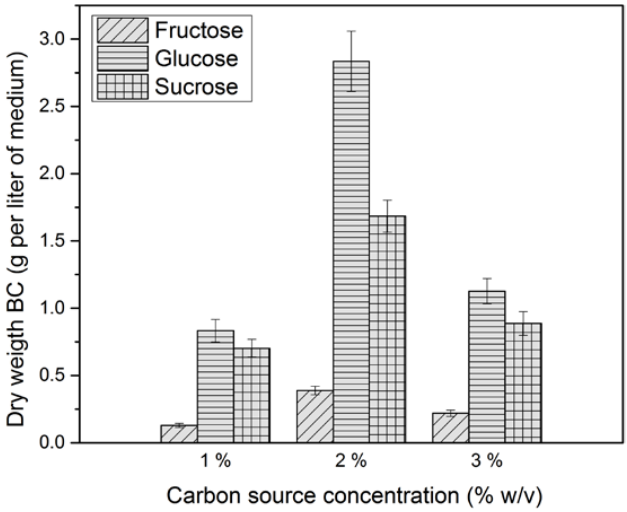
Figure 1. Bacterial cellulose yield in each carbon source culture medium at 1, 2, 3% w / v at the eighth day of fermentation.